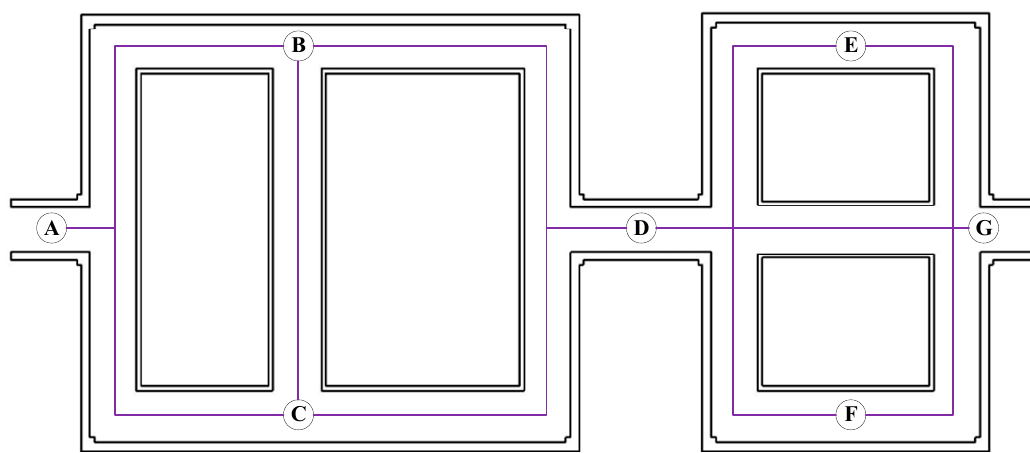
Table 1. In the table, a single node indicates that there is a nesting phenomenon of the node, and analyzes its construction buffer time. The nodes are connected to represent the allocation path of the material, and the time includes the time passing through the starting node. Therefore, on the same path, different starting nodes will lead to different allocation times.